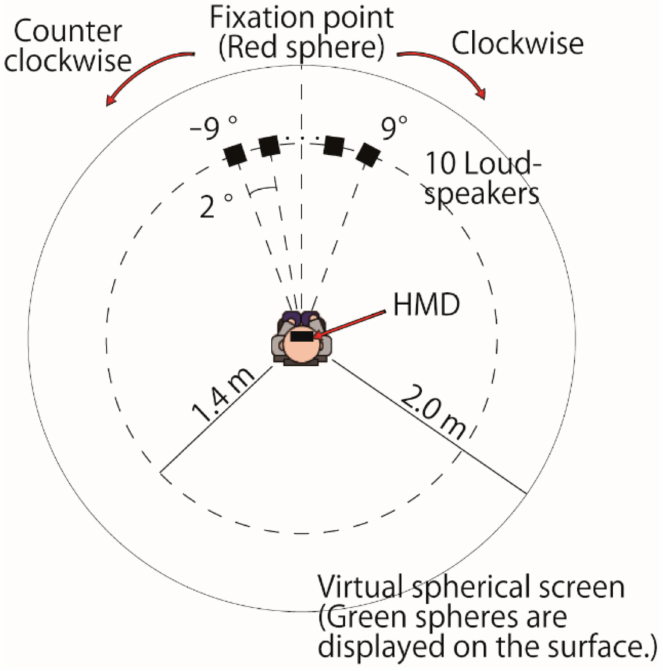
Figure 1. Diagram of the experimental